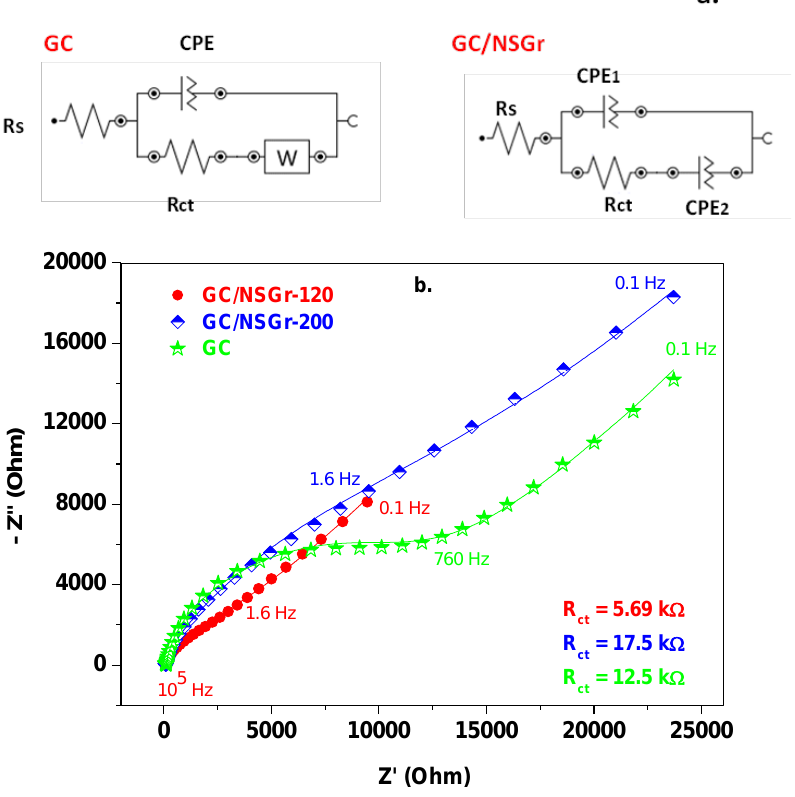
Figure 9. Equivalent electrical circuits employed to fit the EIS data ( a ); Nyquist plots obtained for bare GC (green), GC/NSGr-200 (blue), and GC/NSGr-120 (red) electrodes in solution containing 1.0 mM K4[Fe(CN)6] + 0.2 M KCl; applied potential: +0.3 V ( b